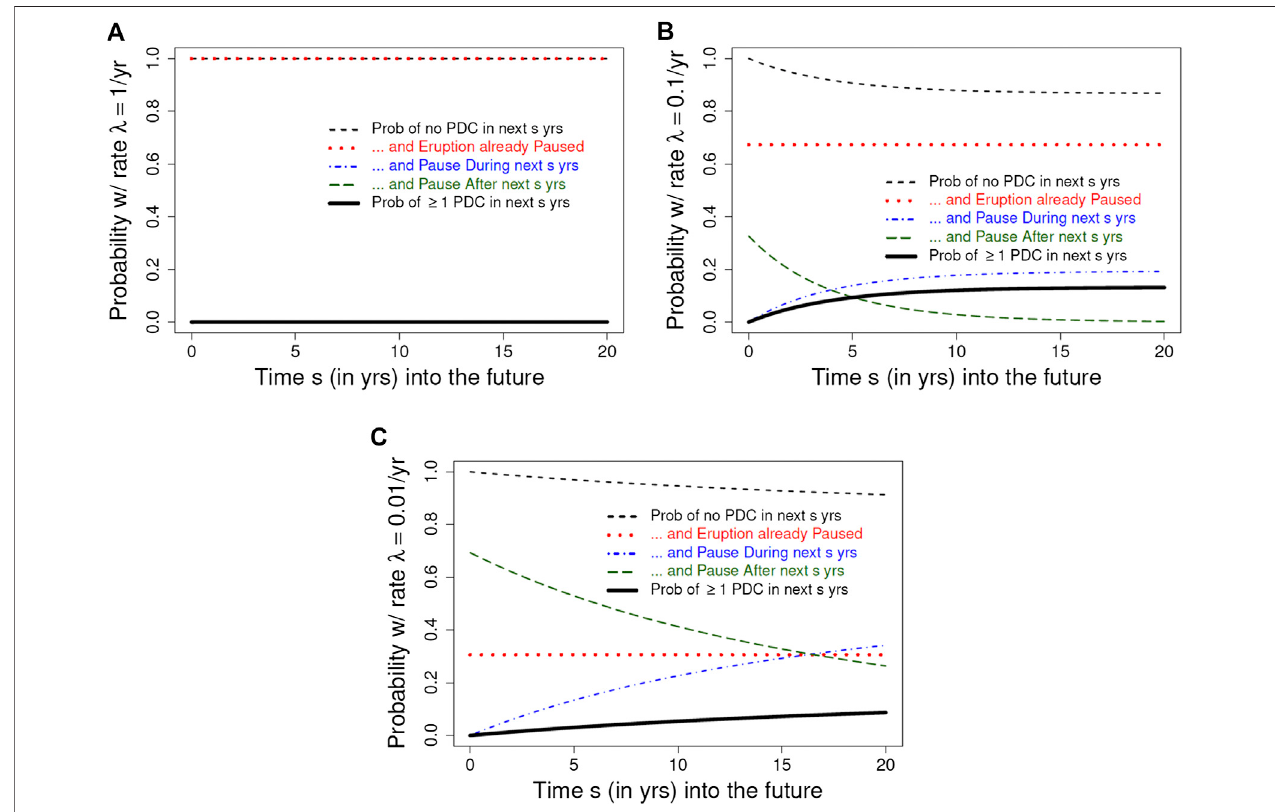
FIGURE3| Solidblackcurveshowsforecastprobability(nearlyzero)ofatleastonePDCin s years,for0 ≤ s ≤ 20,starting t (cid:2) 7yearsafterthemostrecenteruption. Assumedactivityratesare (A) λ (cid:2) 1eventperyear, (B) λ (cid:2) 0 . 1 yr − 1 (onceperdecade),and (C) λ (cid:2) 0 . 01 yr − 1 (oncepercentury),onaverage,untiltheuncertaintime T the eruption ends. Thin dashed black curve shows probability of the complimentary event, zero PDCs in s years, as the sum of three parts: the probability the eruption has already paused by time t (red curve); and the probabilities that the eruption pauses during the next s years (blue dash-dot curve) or after the next s years (green dashed curve) without an intervening